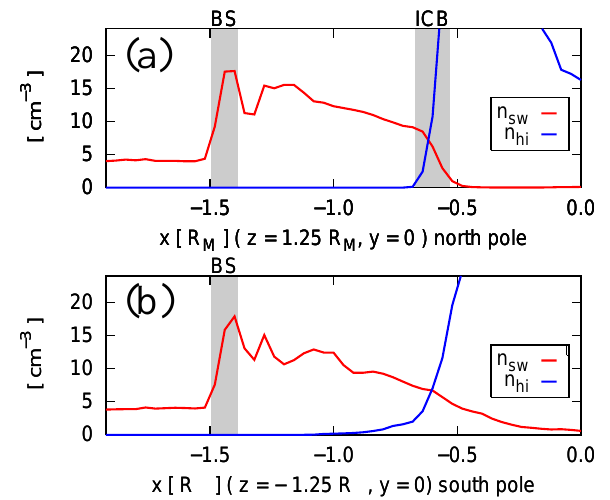
Fig. 13. Cuts along a line parallel to the x-axis in the polar plane at (a) z = 1 . 25 R M (850km above north pole) and (b) z =− 1 . 25 R M (850km below south pole). The ICB, which is clearly developed in the E − hemisphere (a) cannot be seen in the E + hemisphere (b). This results from the different orientation of the electric field in both hemispheres, pointing inwards towards the ionosphere, above the north pole and outwards below the south pole, see also Fig. 10i. Parameters: see Fig. 7.